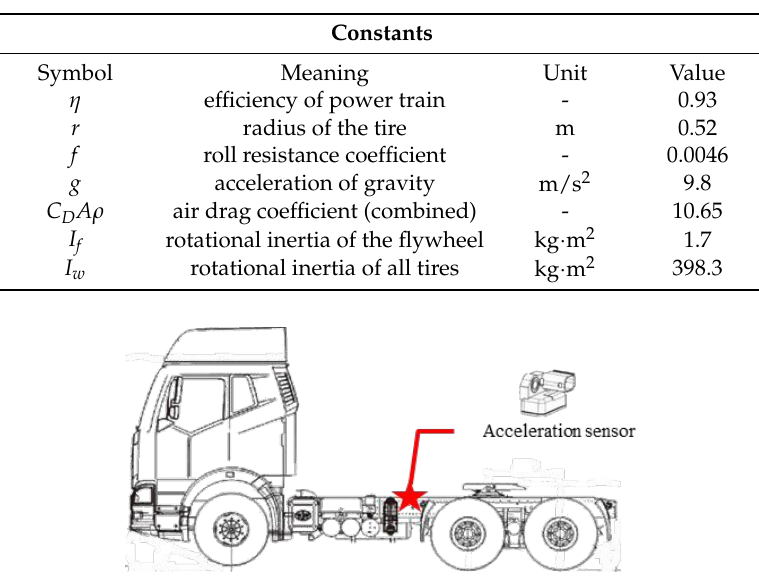
Figure 3. Test vehicle and the installation position of the acceleration sensor.